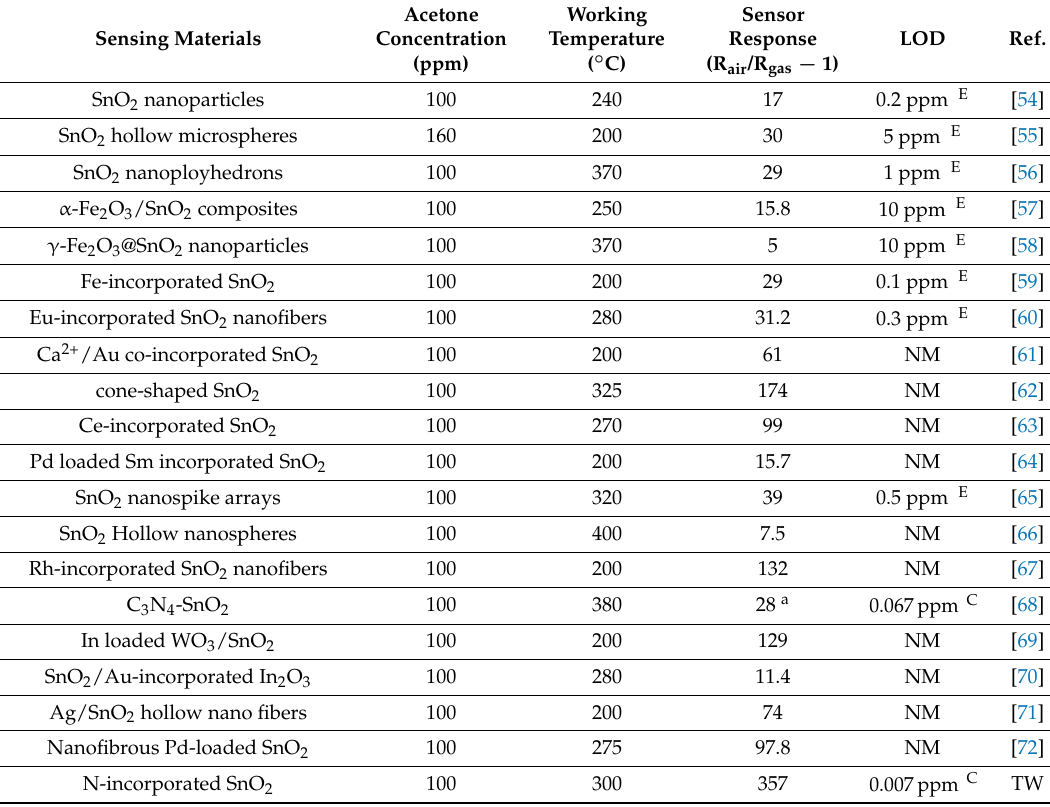
Table 1. Gas responses to acetone of as-prepared N-incorporated SnO 2 and other reported SnO 2